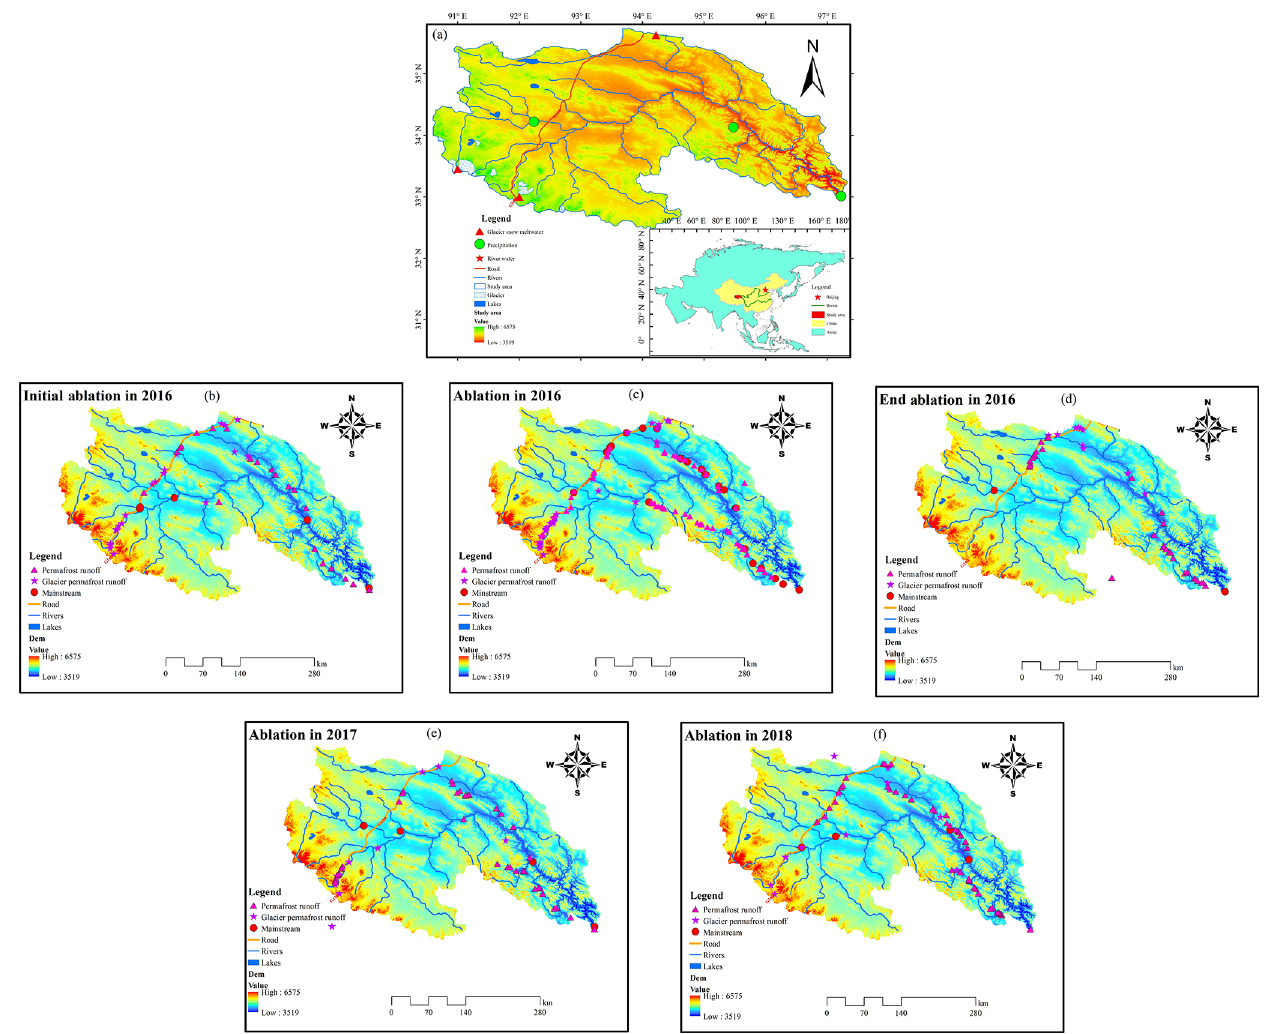
Figure 1. The map of the study area and the sampling point of river water in different ablation periods. ( a shows the detailed location of the study area in China and Asia and the distribution of fixed points for precipitation, river water, and glacier and snow meltwater; b shows the distribution of sampling points in initial ablation in 2016; c shows the distribution of sampling points in ablation in 2016; d shows the distribution of sampling points in end ablation in 2016; e shows the distribution of sampling points in ablation in 2017; f shows the distribution of sampling points in ablation in